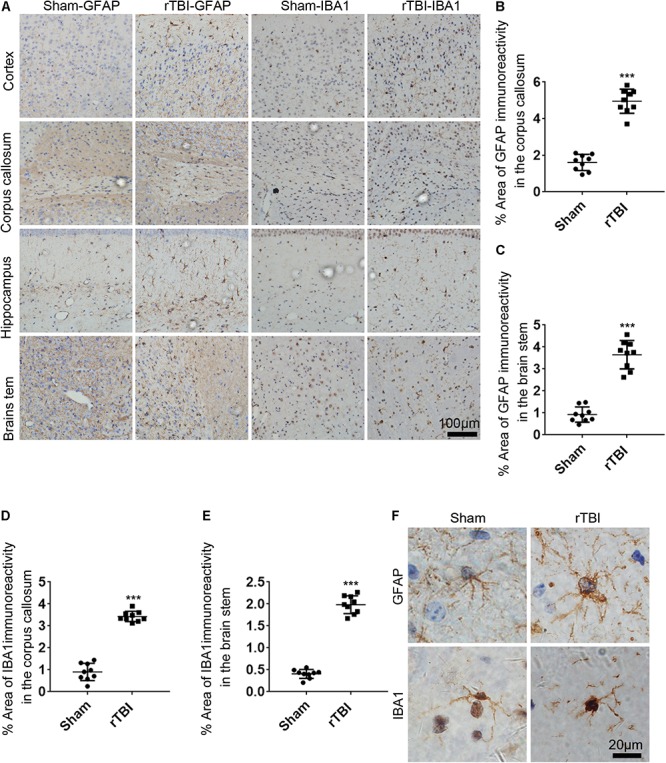
Repetitive traumatic brain injury (rTBI) induces widespread astrogliosis and microglial activation. (A) glial fibrillary acidic protein (GFAP) and ionized calcium binding adaptor molecule 1 (IBA1) staining in the cortex, corpus callosum, hippocampus, and brain stem 72 h after rTBI or the sham-treated group. (B) Quantitative analysis of the intensity of GFAP staining in the corpus callosum. (C) Quantitative analysis of the intensity of GFAP staining in the brain stem. (D) Quantitative analysis of the intensity of IBA1 staining in the corpus callosum. (E) Quantitative analysis of the intensity of IBA1 staining in the brain stem. (F) Representative × 100 magnified images showing the morphology of GFAP-stained astrogliosis and IBA1-stained microglia in the hippocampus. Data are presented as the mean ± SD (t-test, ∗∗∗P < 0.0001).